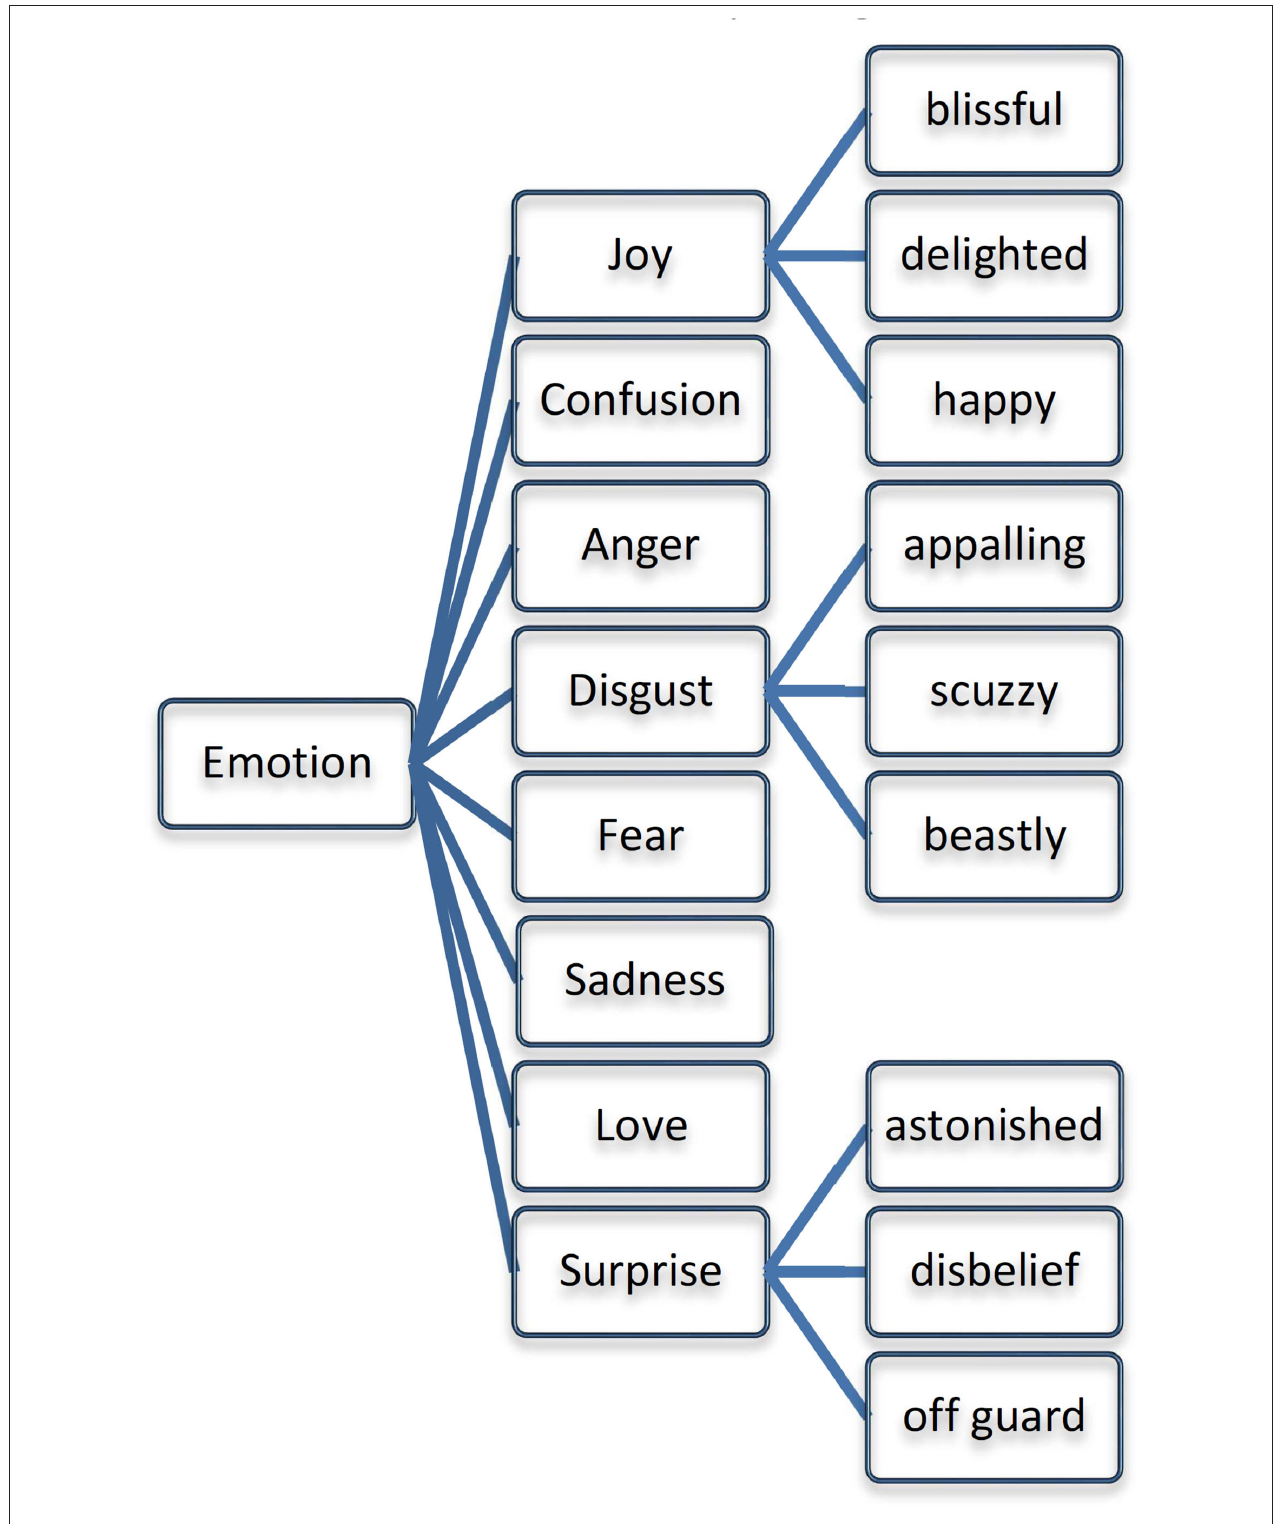
FIGURE 2 | Fundamental emotions list for ontology